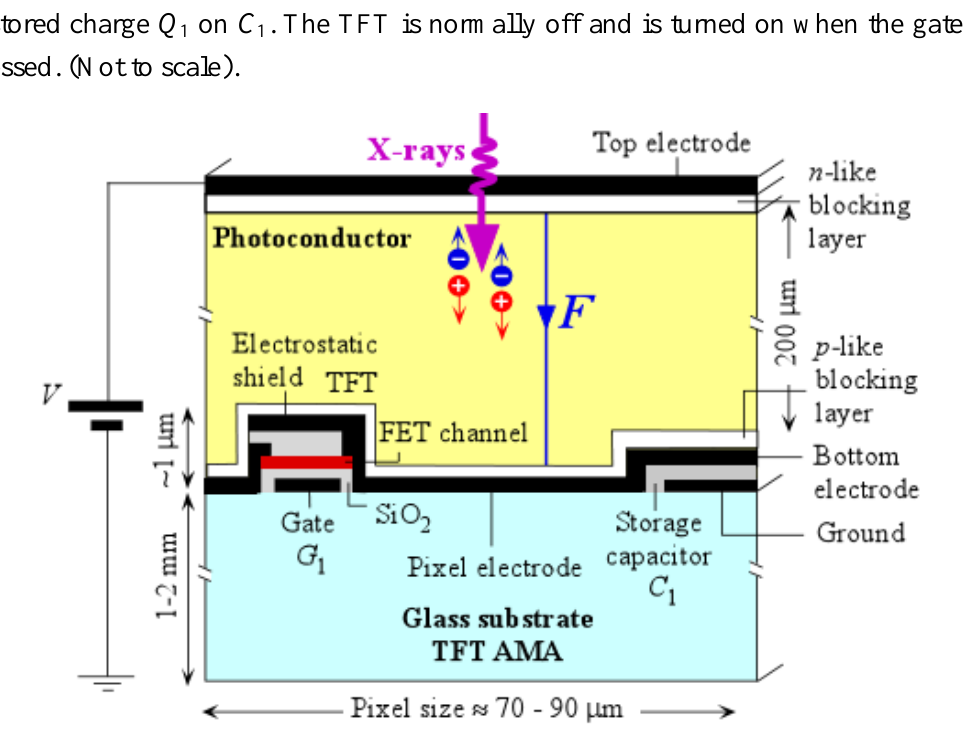
Figure 2. A simplified schematic diagram of the cross section of a single pixel with a TFT. The charges generated by the absorption of x-rays drift towards their respective